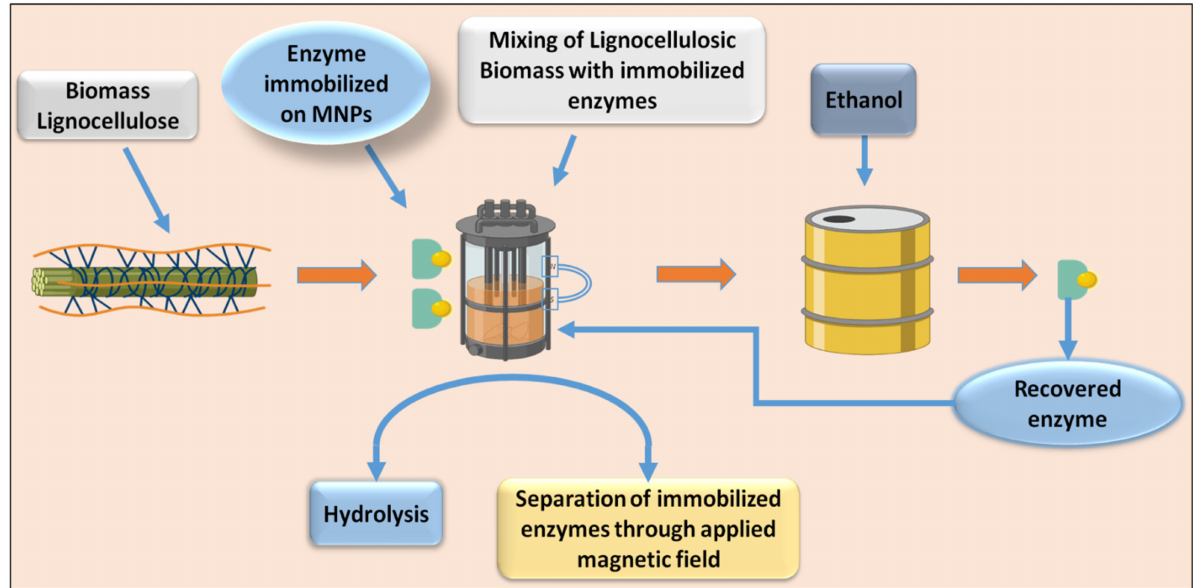
Figure 2. Biofuel production with the use of cellulase incorporated in MNPs (magnetic nanoparticles) to break down